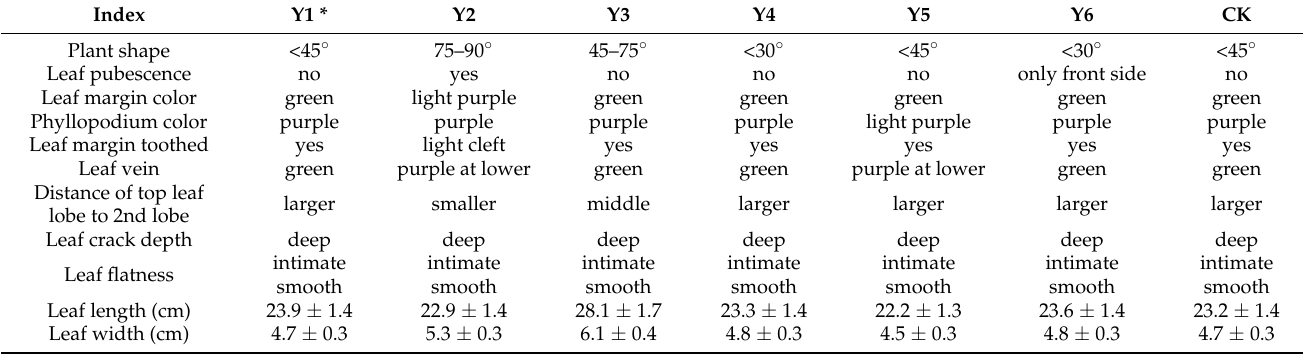
Table 1. Morphological evaluation of dandelion progenies.